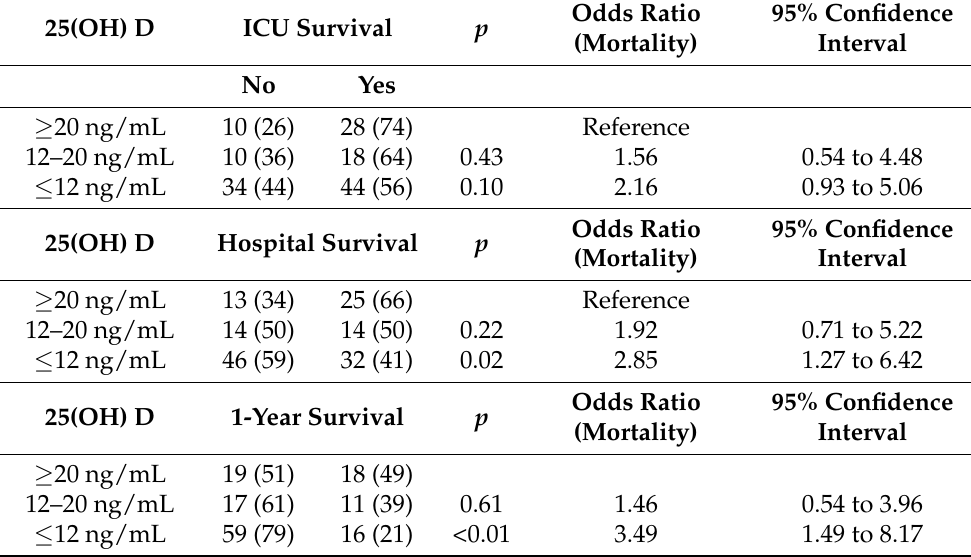
Table 3. Contingency tables and unadjusted odds ratios for survival outcomes according to 25(OH) D levels.